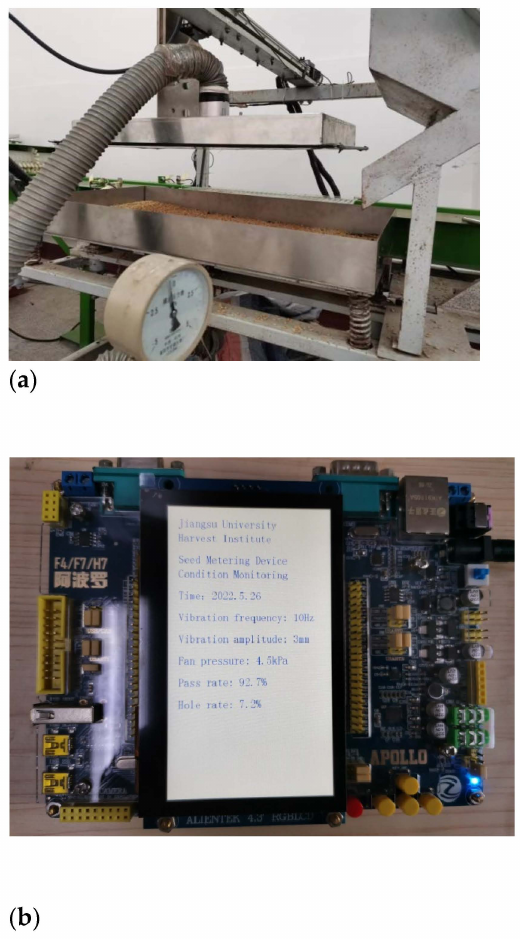
Figure 11. Field bench test of the monitoring system of air suction vibrating disk seed metering device. ( a ) Test platform of air suction vibrating disc seed metering device; ( b ) Main controller monitoring